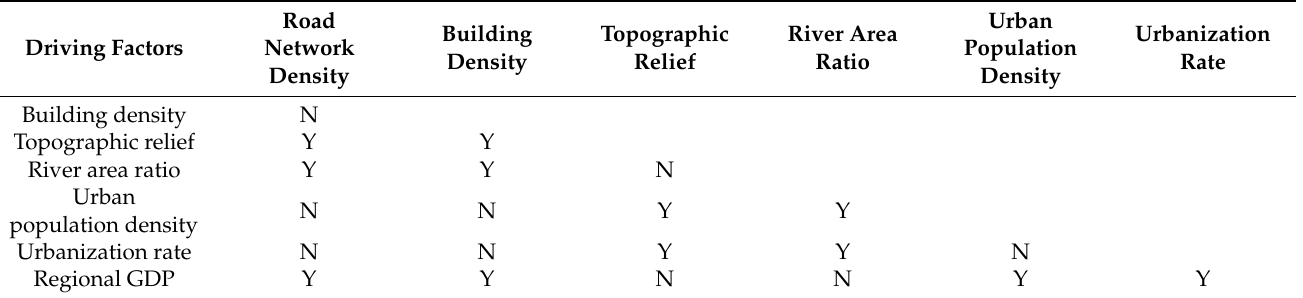
Table 5. Ecological detection